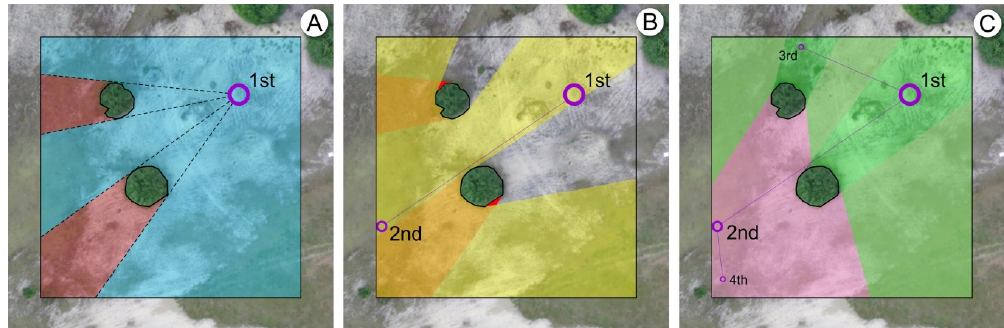
Figure 1. Isovist minimum viewpoint set (MIS) construction: a single viewpoint ( A ) gives an overview of most of the landscape and is, therefore, regarded as a primary viewpoint. To see obstructed areas (shaded in red), a secondary viewpoint is necessary ( B ). However, two small obscured areas remain in red; thus, two more viewpoints ( C ) are positioned by the MIS algorithm. Full visual coverage of the landscape, therefore, is provided by four viewpoints.